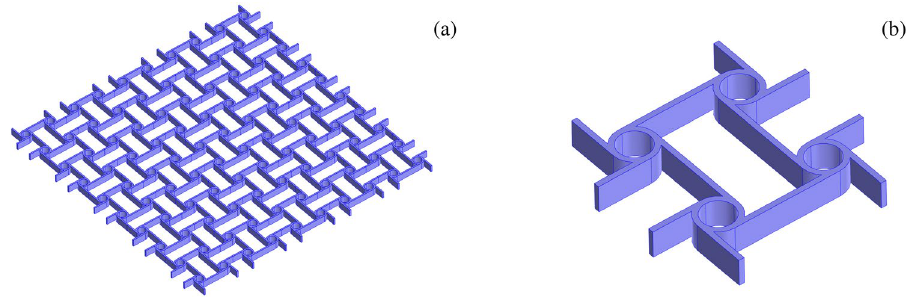
Figure 1. ( a ) A generic portion of an anti-tetrachiral metamaterial. ( b ) Its elementary cell.